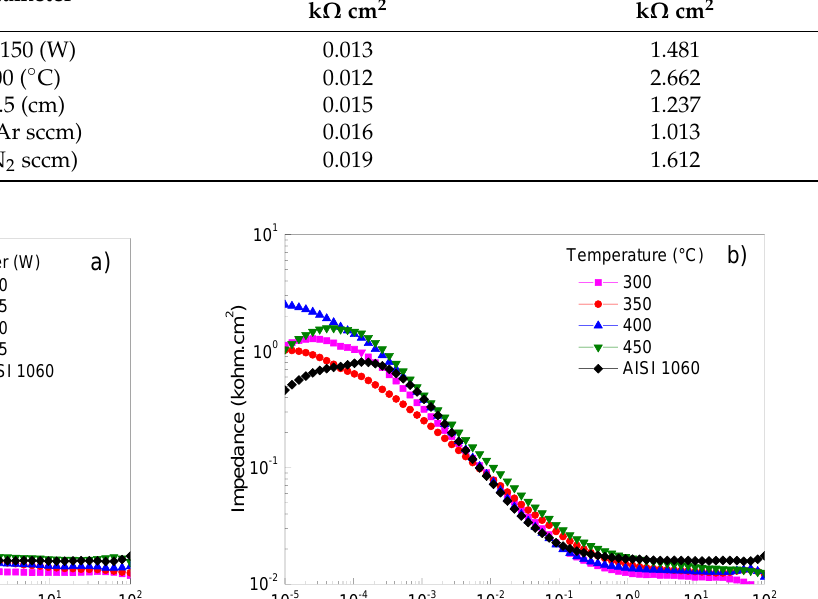
Table 4. Fitting results of EIS curves with the best behavior immersed in 3.5% NaCl solution. Parameter